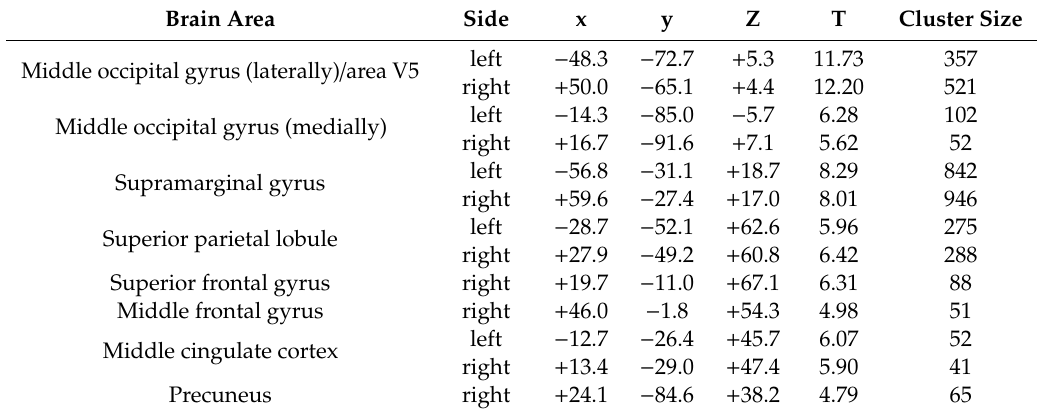
Table 3. Structures activated during the active contrast task in action observation (AO)